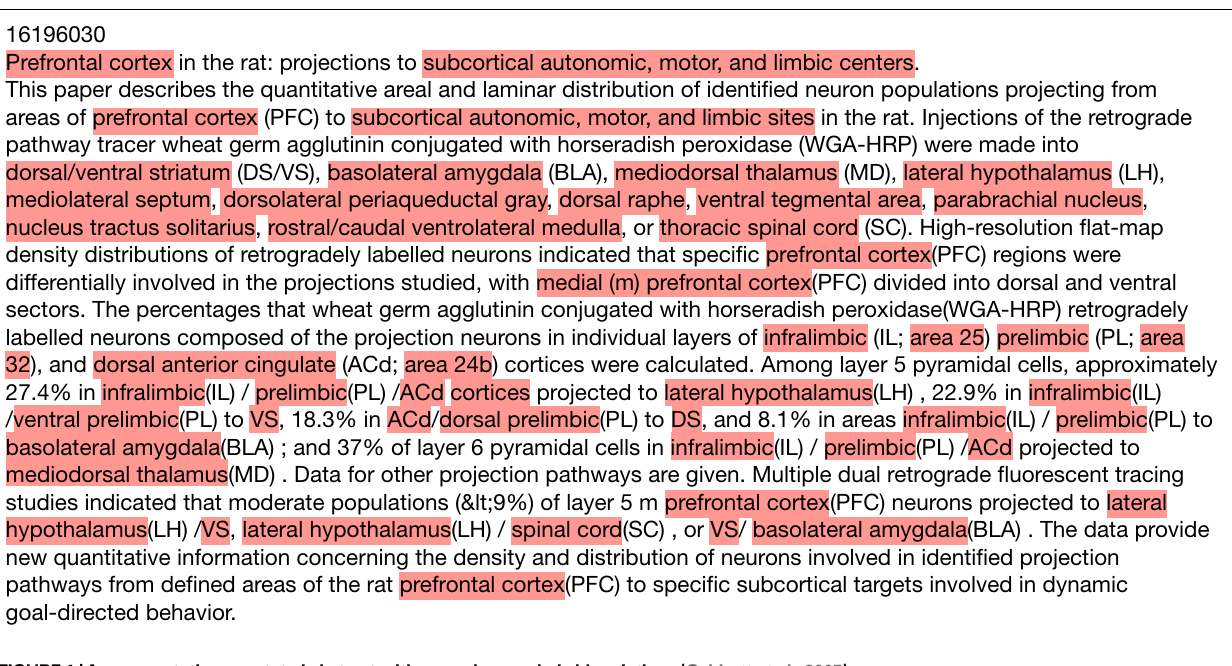
FIGURE 1 | A representative annotated abstract with several expanded abbreviations (Gabbott et al.,